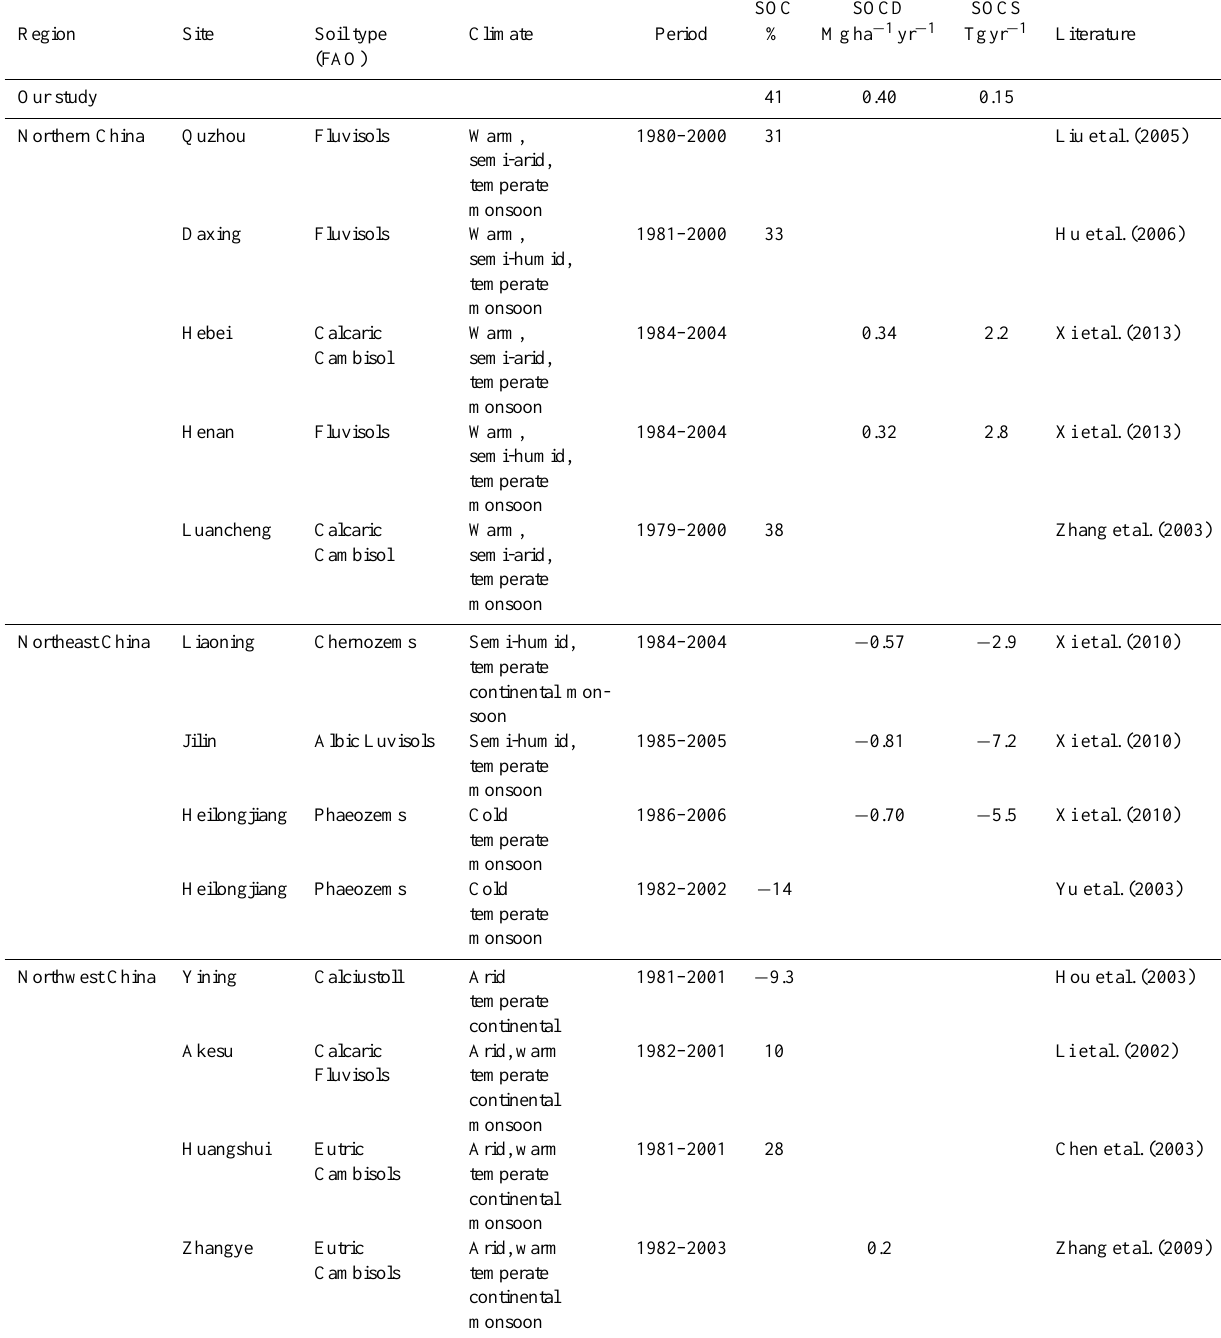
Table 3. Topsoil (0–20cm) SOC change from 1980s to 2000s in different agronomic regions of China ∗